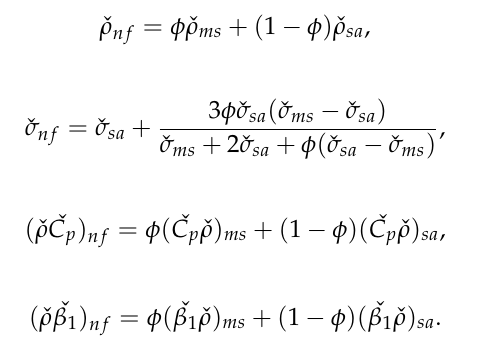
Table 2 communicates the operational values for physical and thermal quantities of NaAlg and MoS 2 . Table 2. Values for thermo-physical quantities of NaAlg and MoS 2 [29,46].